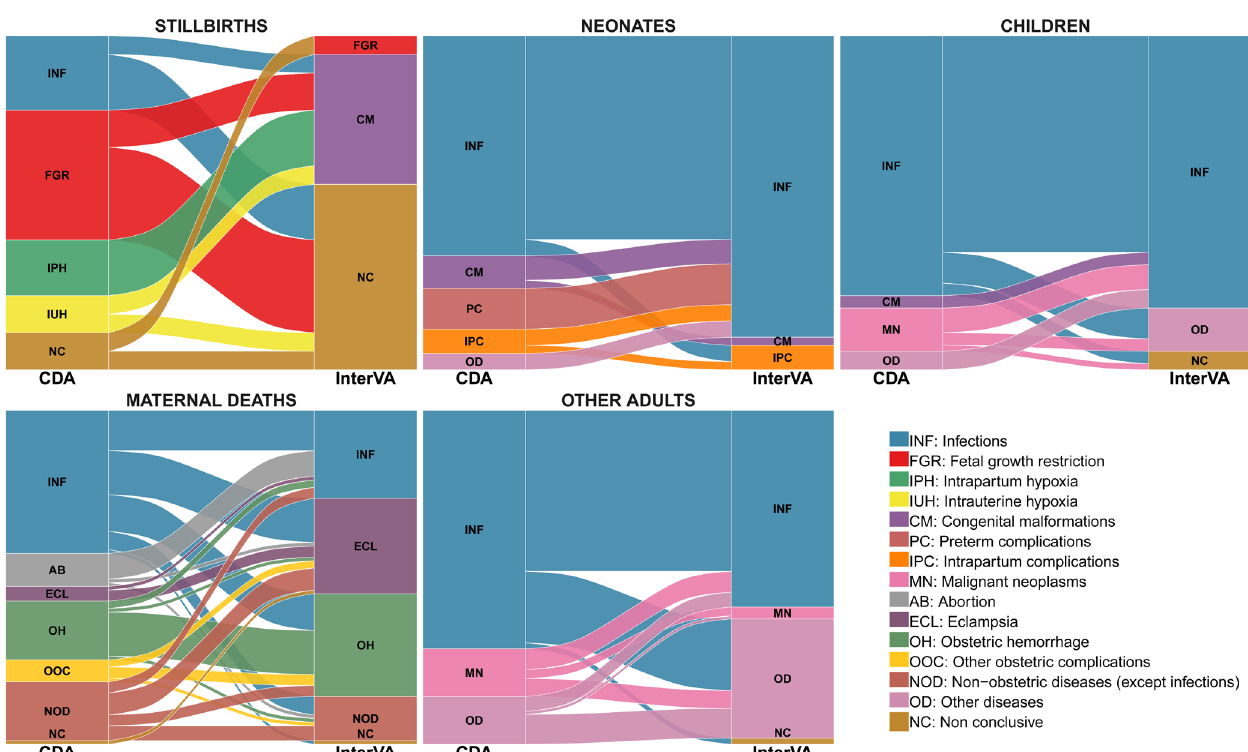
Figure 1. Alluvial diagrams of the differences in assignment of individual causes of death established by the Complete Diagnostic Autopsy (CDA) and InterVA (Interpreting Verbal Autopsy) model by study group. The stacked blocks represent the causes of death (CoDs) determined by the CDA (left) and by the InterVA model (right), and their size as proportional to the cause-specific mortality fractions (CSMFs). The branches between blocks represent differences in the composition of the CoDs between the CDA and the InterVA model, being their thickness proportional to the number of cases contained in both blocks connected by the branch. Each CoD is represented by a different color, which is the same in both diagnostic methods. The color of the branches is determined by the cause of actual death (CDA). The concordant cases between the CDA and the InterVA model are represented by branches connected to blocks of the same color. In contrast, misclassified cases are shown as branches connected to blocks of different color.